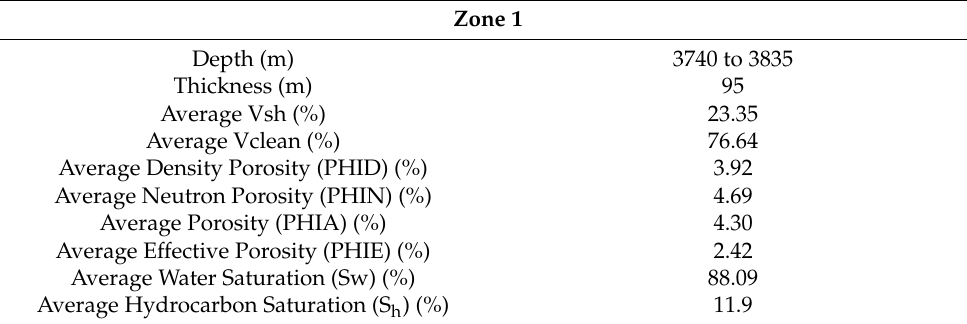
Table 7. Petrophysical analysis results obtained for zone 1.